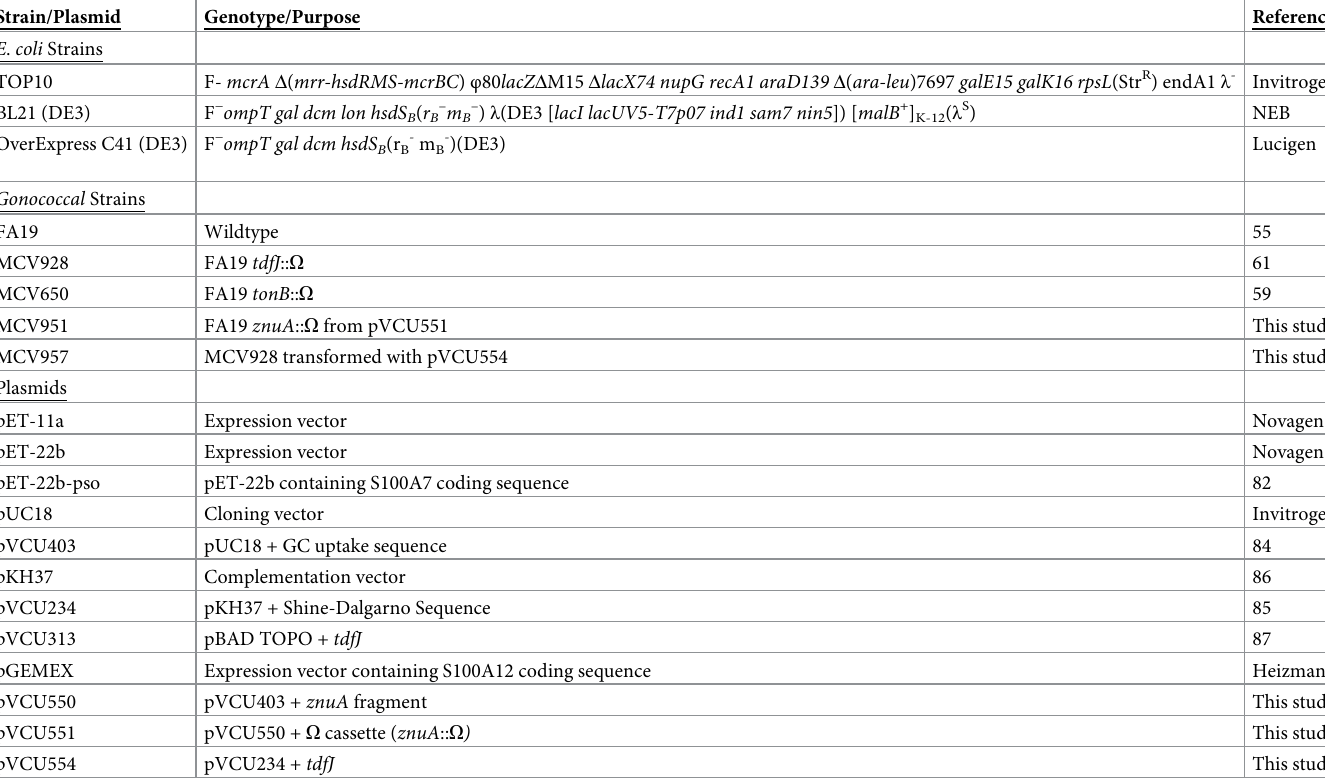
Table 2. Strains and plasmids used in this